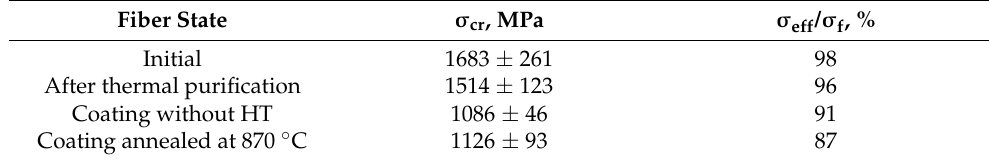
Table 5. Strength of composite rods ( σ cr ) and relative effective fiber strength ( σ eff / σ f ) in different